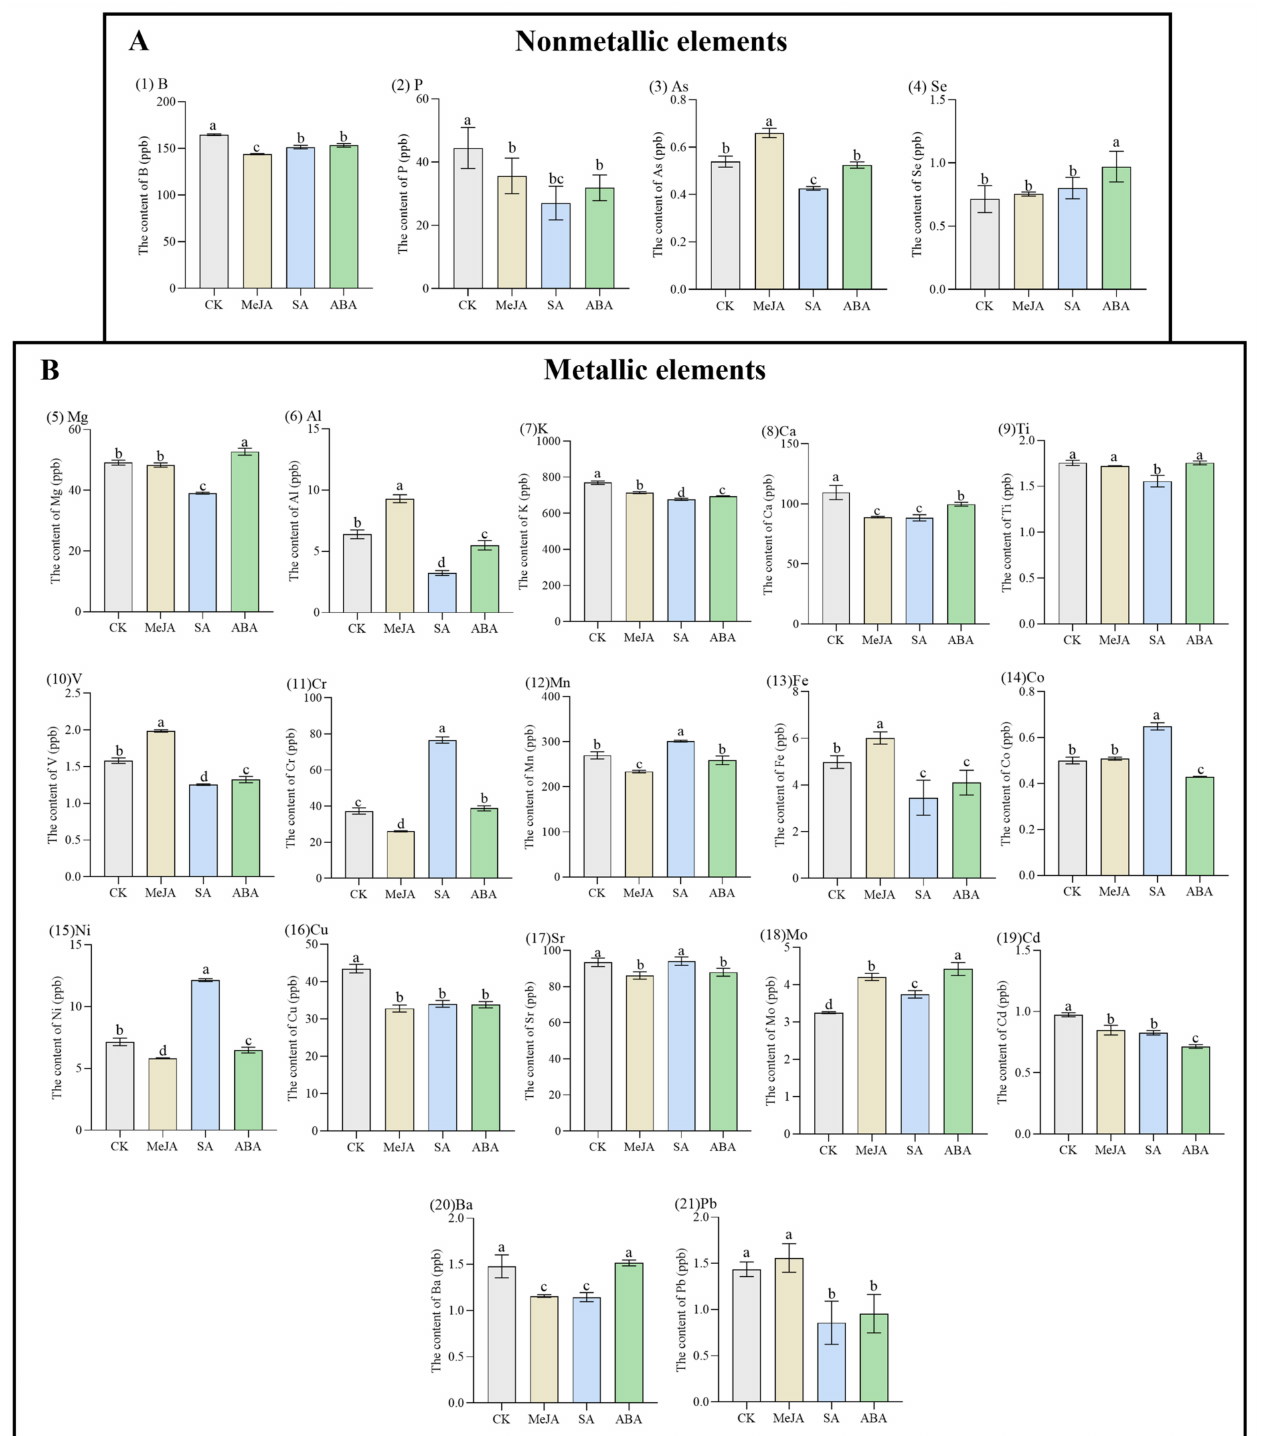
Figure 2. Contents of nonmetallic elements ( A ) and metal elements ( B ) in A. argyi leaves. The data are expressed as the means ± standard deviations (SDs, n = 3). The different lowercase letters indicate significant differences between treatments ( p < 0.05) by Duncan’s single-factor variance